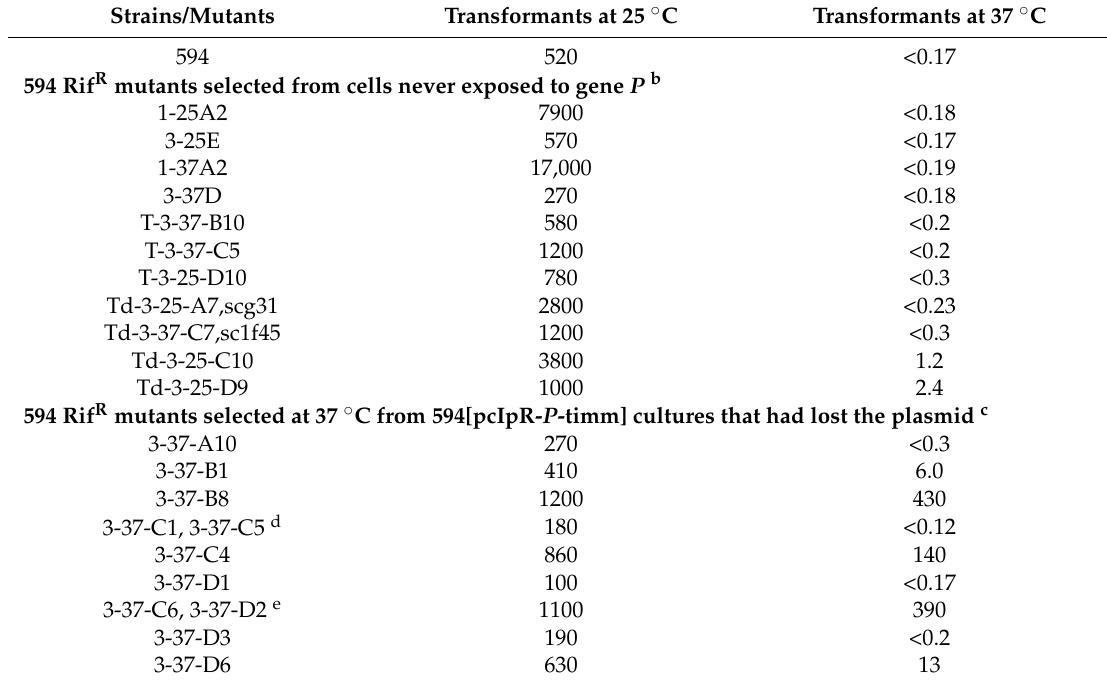
Table 6. Transformation ( ˆ 10 ´ 7 ) of pcIpR- P -timm/100 ng plasmid into Rif R mutants of 594 a . Strains/Mutants Transformants at 25 ˝ C Transformants at 37 ˝ C 520